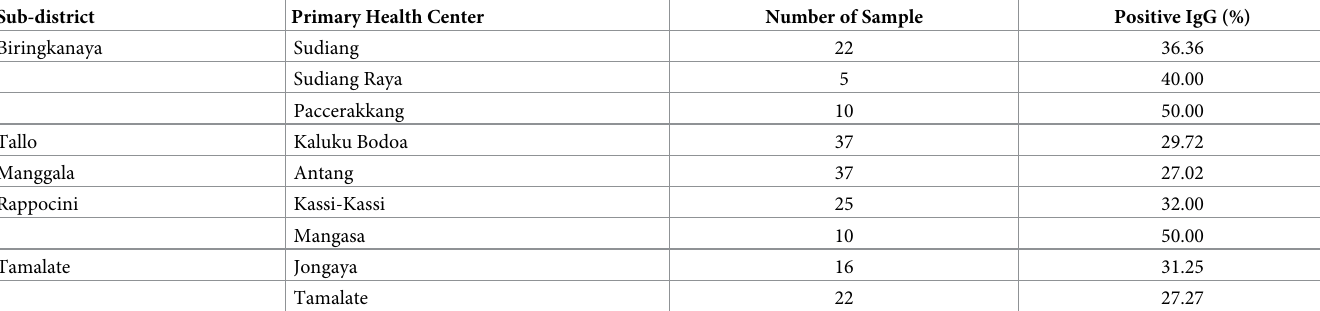
Table 2. Distribution of positive Toxoplasma IgG antibody in Sub-districts in Makassar Indonesia.